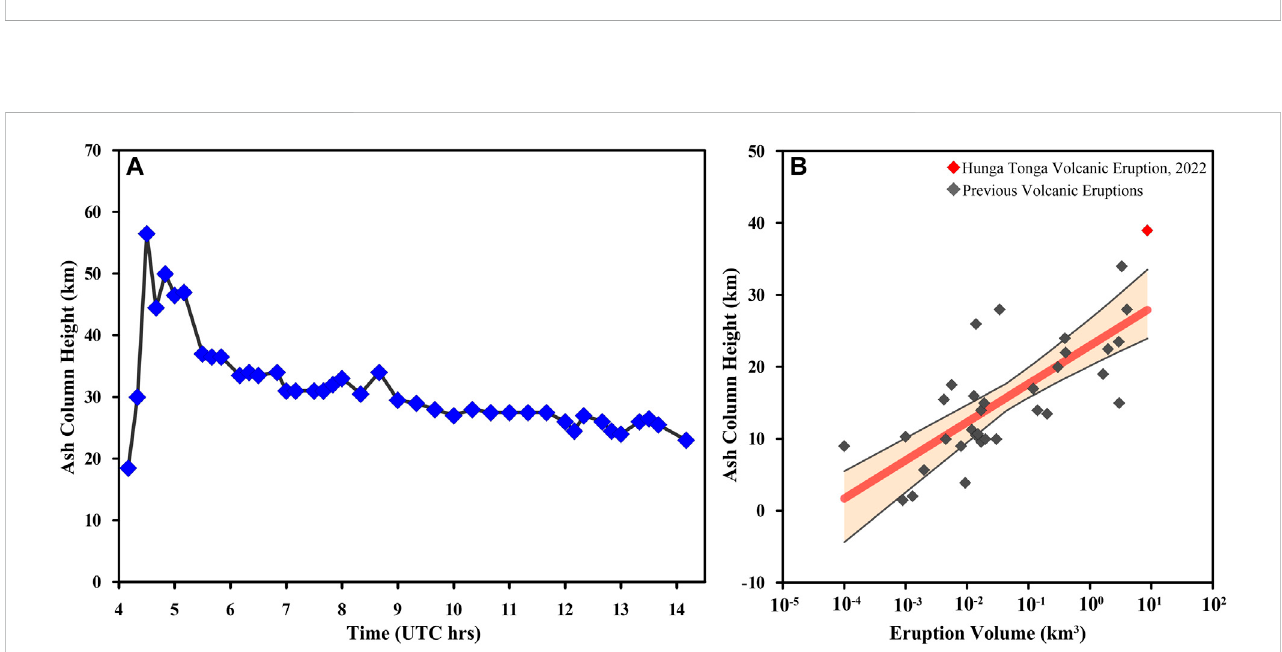
FIGURE 3 LogarithmicvalueofpressurechangebyarrivalofsecondwaveS 2 ,thirdwaveS 3 ,andfourthwaveS 4 versus logarithmicvalueofthedistanceoftheLamb wave traveled around the globe in different phases (shown in Figure 1C) to reach the same stations from the Hunga Tonga eruption location/source. Gray areas represent the 95% con fi dence level area of the dataset.